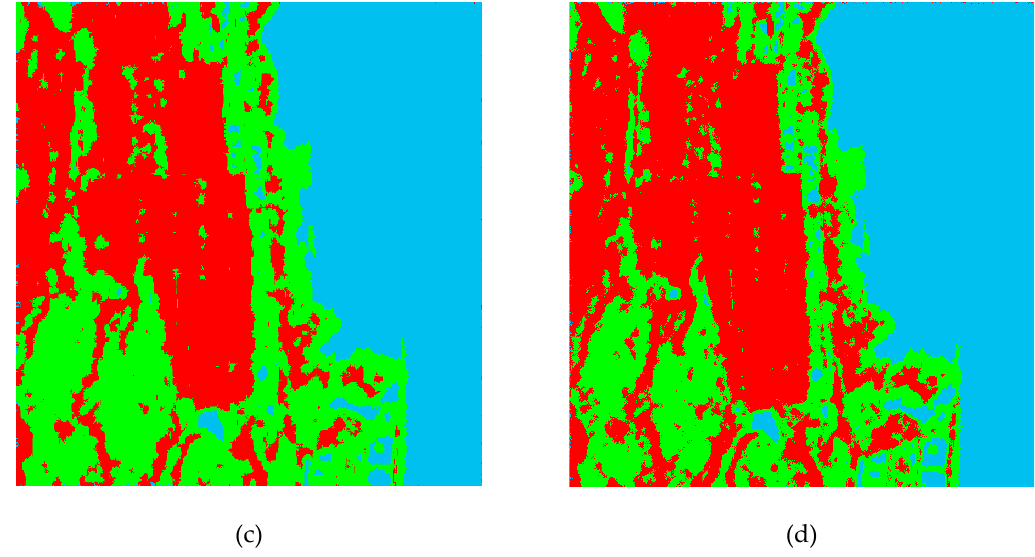
Figure 7. Pixel-based classification results for the Fujian data. ( a ) WMRF. ( b ) KMRF. ( c ) MWMRF. ( d ) MWMRF/e. Table 1. Comparison of the pixel-based classification algorithms for the Flevoland data.